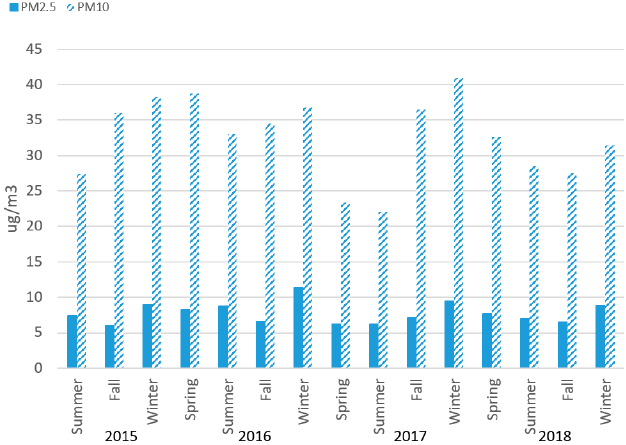
Figure 1. Median values (average 24-h measurements) of PM 2.5 and PM 10 , Imperial Community Air Monitoring Network, 2015–2018, by season. Hours with less than 75% of completed 5-min measurements and days with less than 75% of completed 1-h measurements are excluded. Spring 2015 excluded due to low numbers of